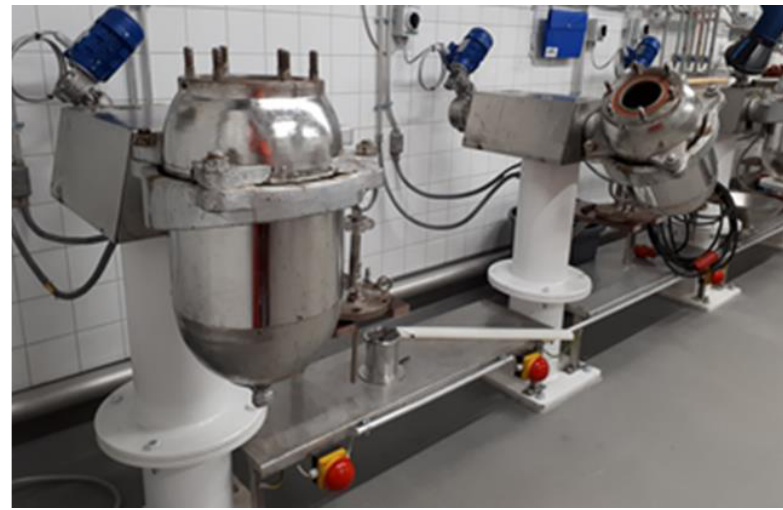
Figure 1. The straw material was processed in 15 L reactors.